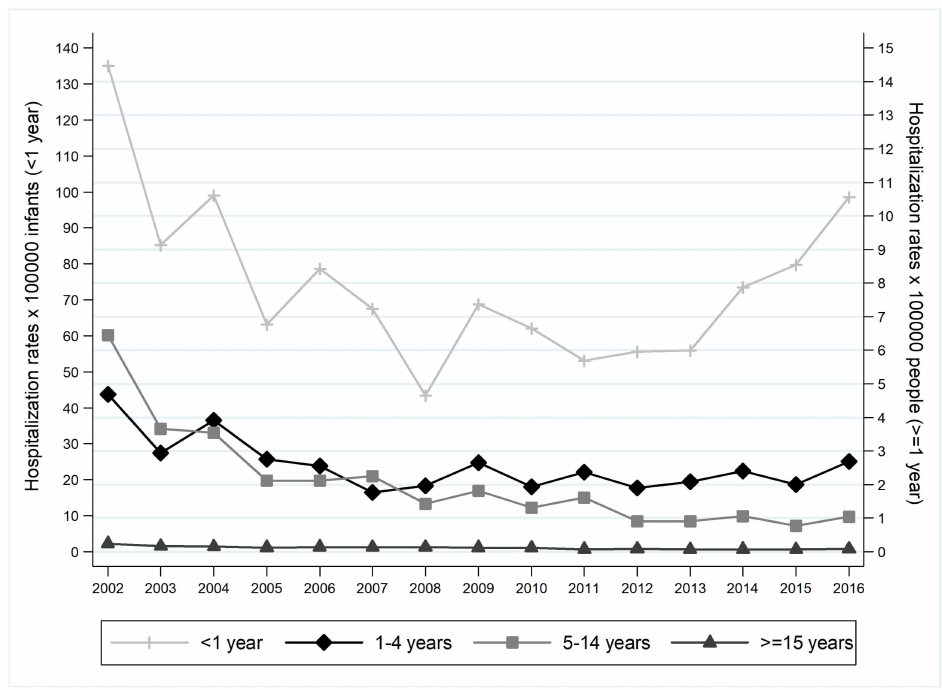
Figure 3. Hospitalization rates × 100000 people by age groups. Trend test. < 1 year: β coe ffi cient = − 1.87, p = 0.186; 1–4 years: β coe ffi cient = − 0.11, p = 0.015; 5–14 years: β coe ffi cient = − 0.28, p < 0.001; β coe ffi cient = − 0.01, p < 0.001.